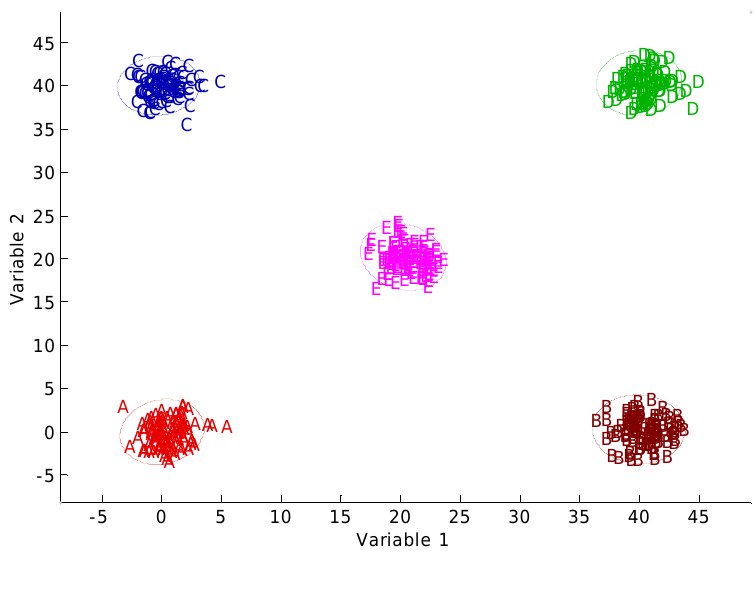
Figure 7. Two-variable plot of the synthetic novel class data set. A, B, C, and D denote the training sets, and E denotes the test set. The 95% confidence intervals were calculated around each training class.